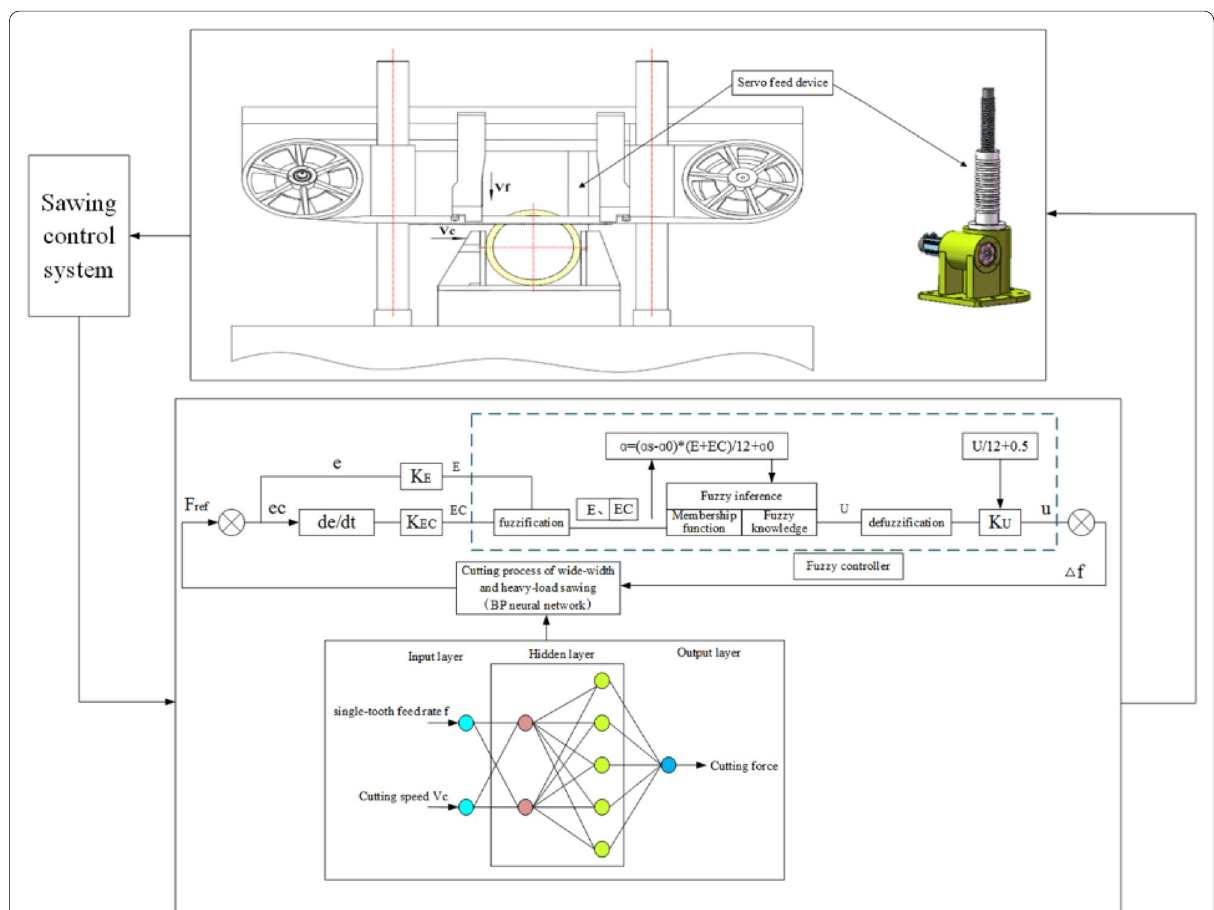
Figure 17 Active flutter suppression control strategy for wide-width and heavy-load